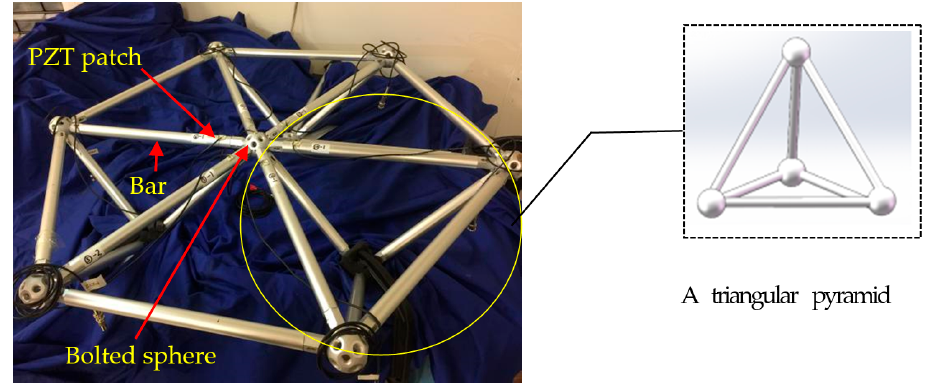
Figure 3. Photo of triangle-on-triangle offset grid specimen.